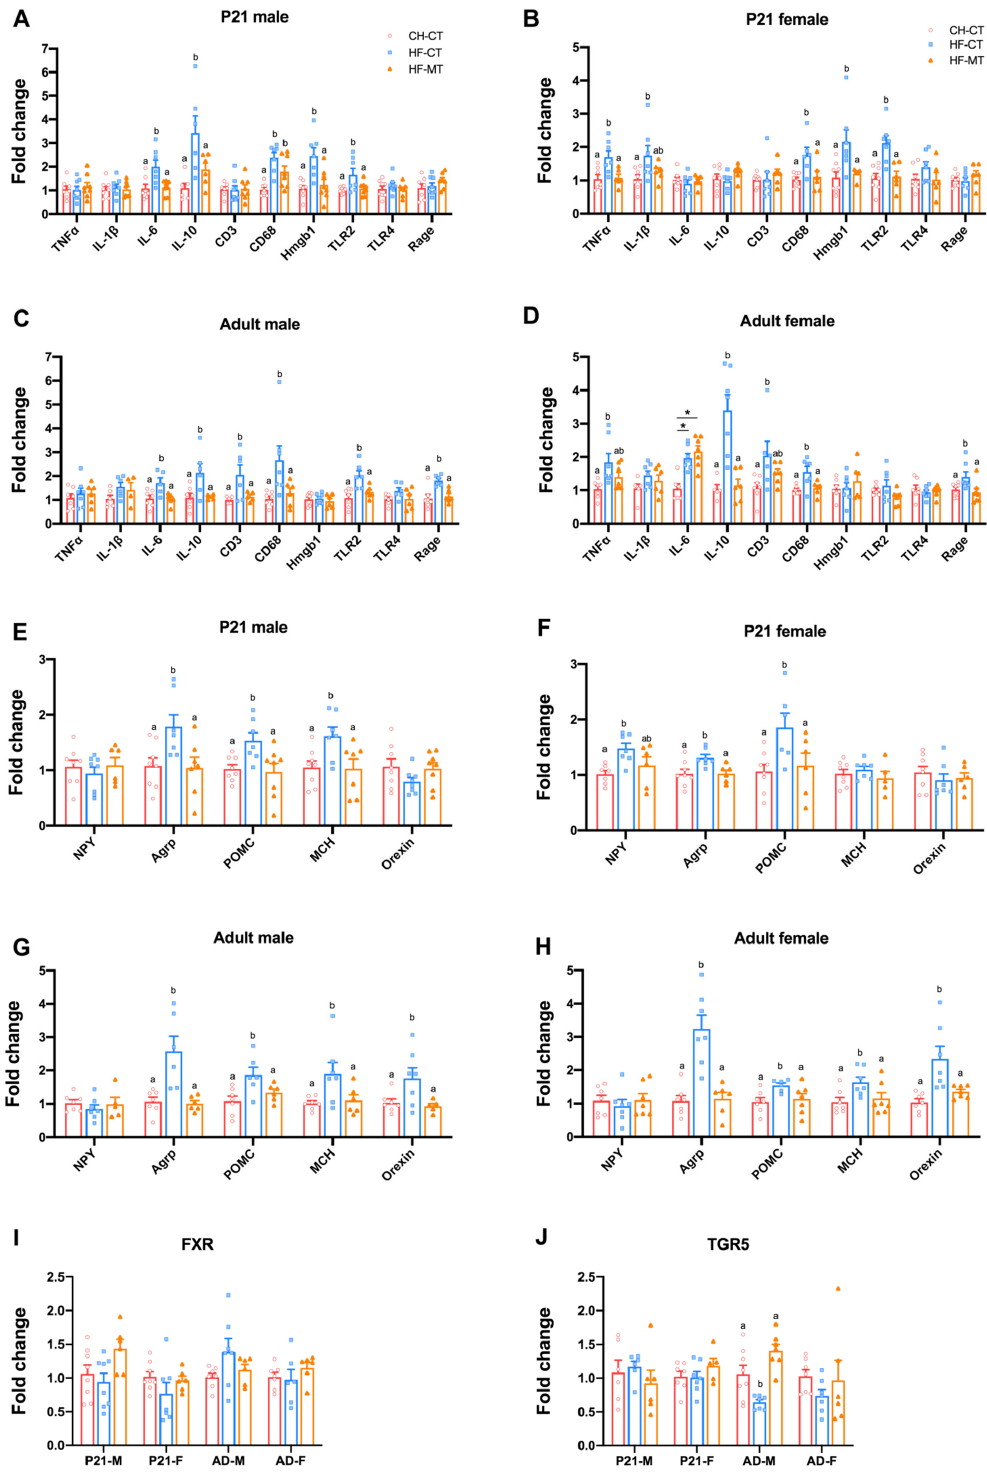
Figure 6. Maternal metformin treatment improves hypothalamic gene expression of inflammatory and appetite markers in offspring from high-fat fed dams and restores hypothalamic gene expres- sion of bile acid receptor-TGR5 in adult male offspring: ( A , B ) hypothalamic mRNA expression of inflammatory markers in male and female pups at weaning; ( C , D ) hypothalamic mRNA expression